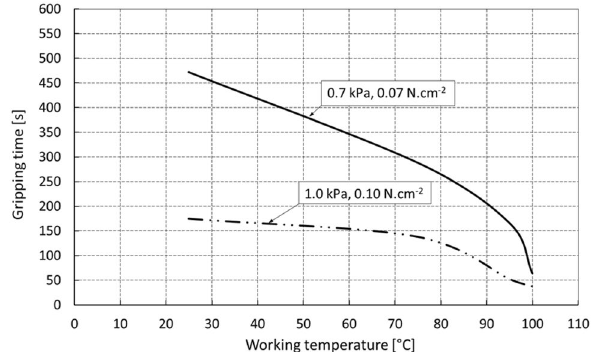
Fig. 12 Gripping time depending on the operating temperature for different gripping element loads